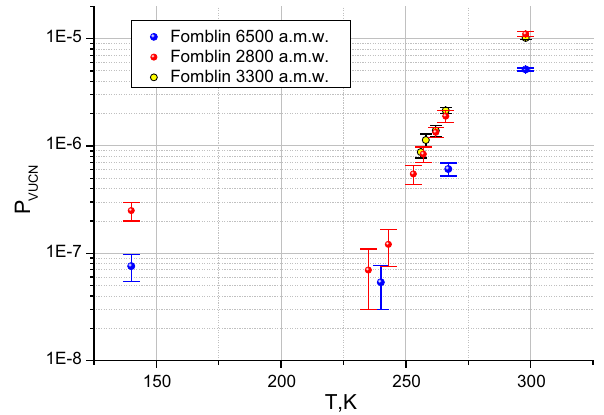
Fig. 3 Temperature dependence of the probability of small heating to the energy range of 35 ÷ 140neV for Fomblin Y oils